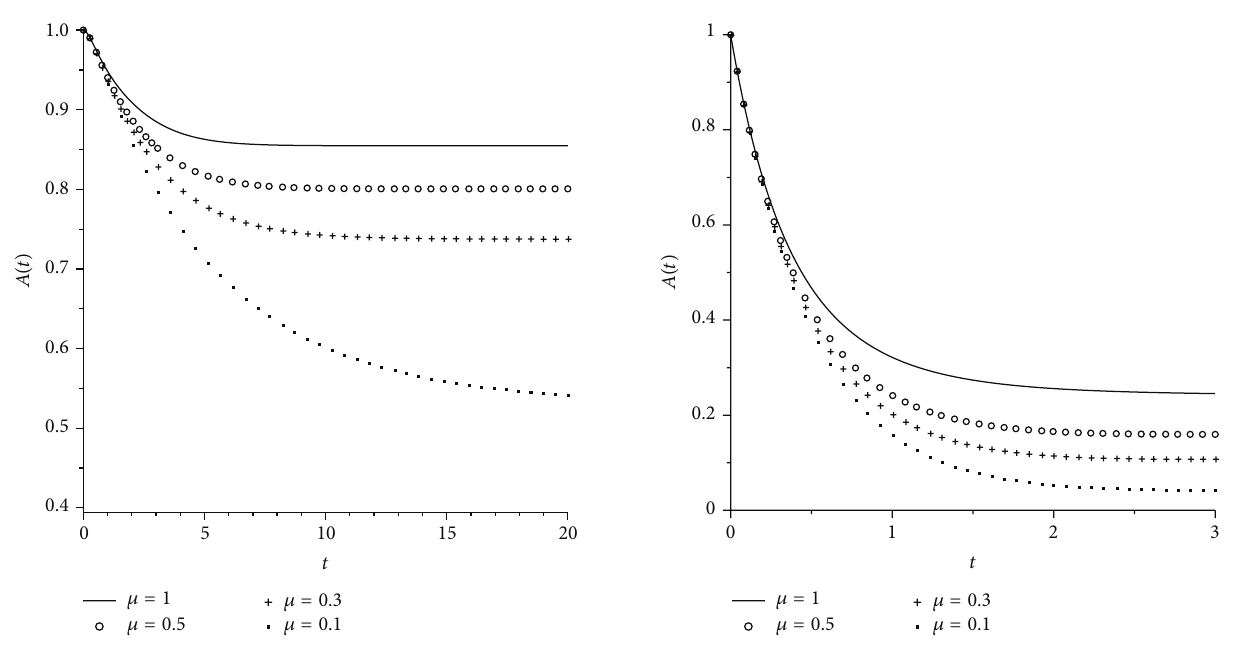
Figure 1: Instantaneous availabilities of the system with warning device with different 𝜇 .